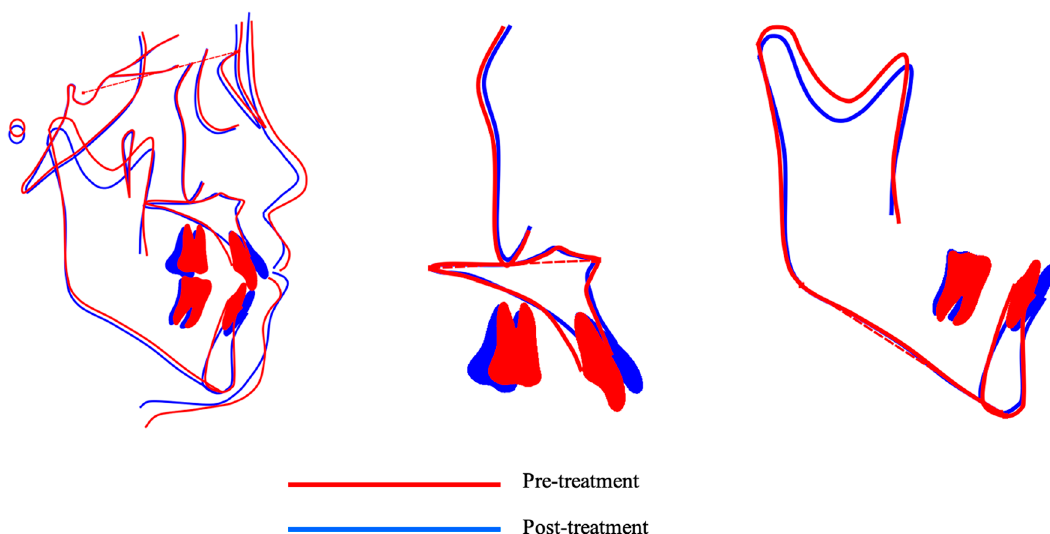
Figure 8. Final study models.